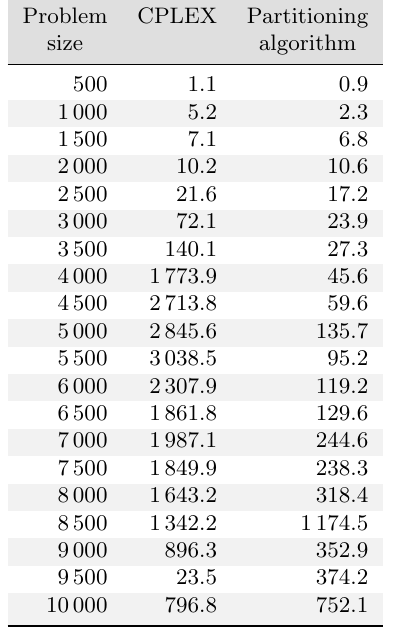
Table 1: Standard deviations of the solution times for the partitioning algorithm and